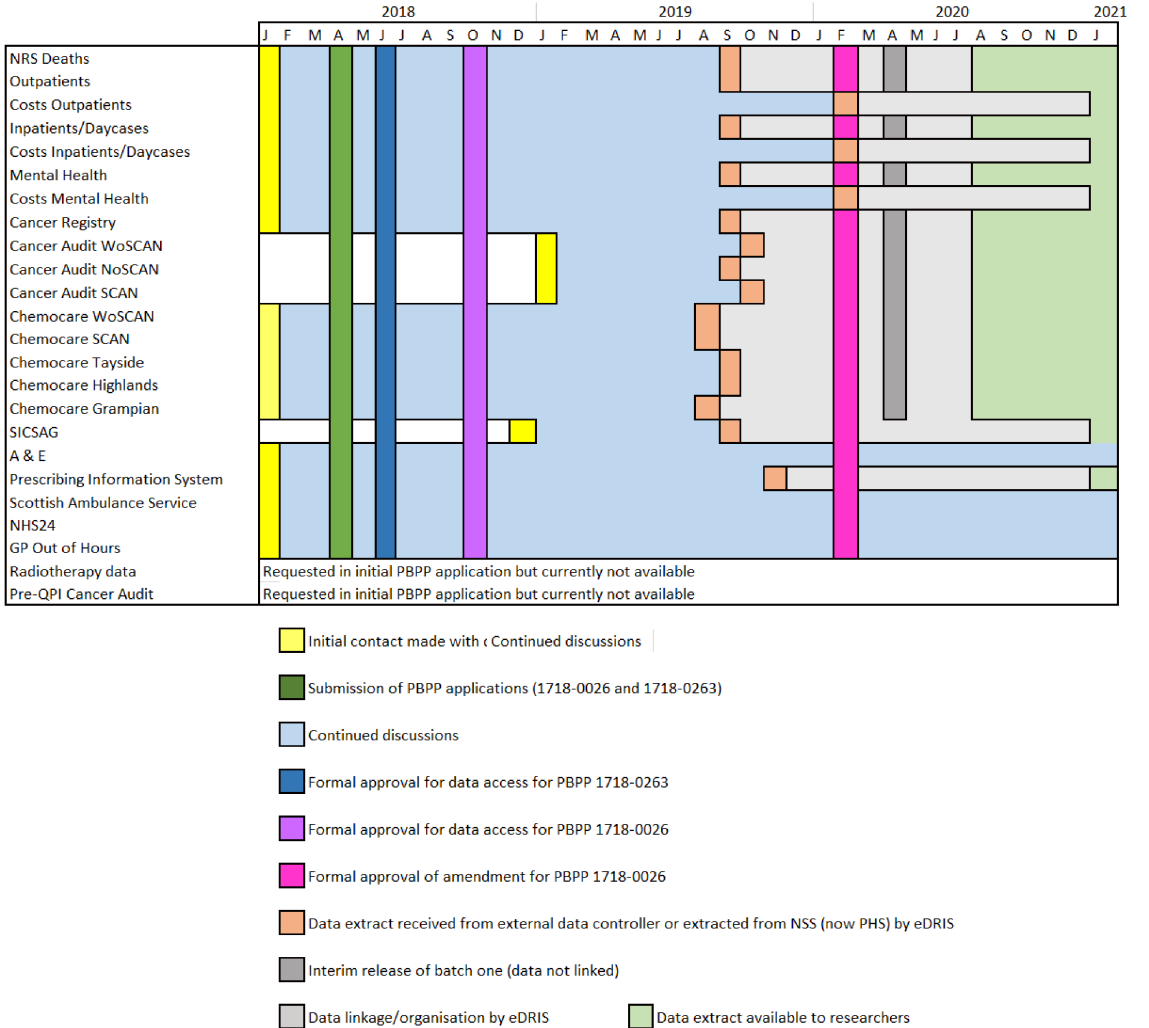
Figure 4: Timeline for transfer of datasets to PHS. As of January 2020, 32 individual data files were